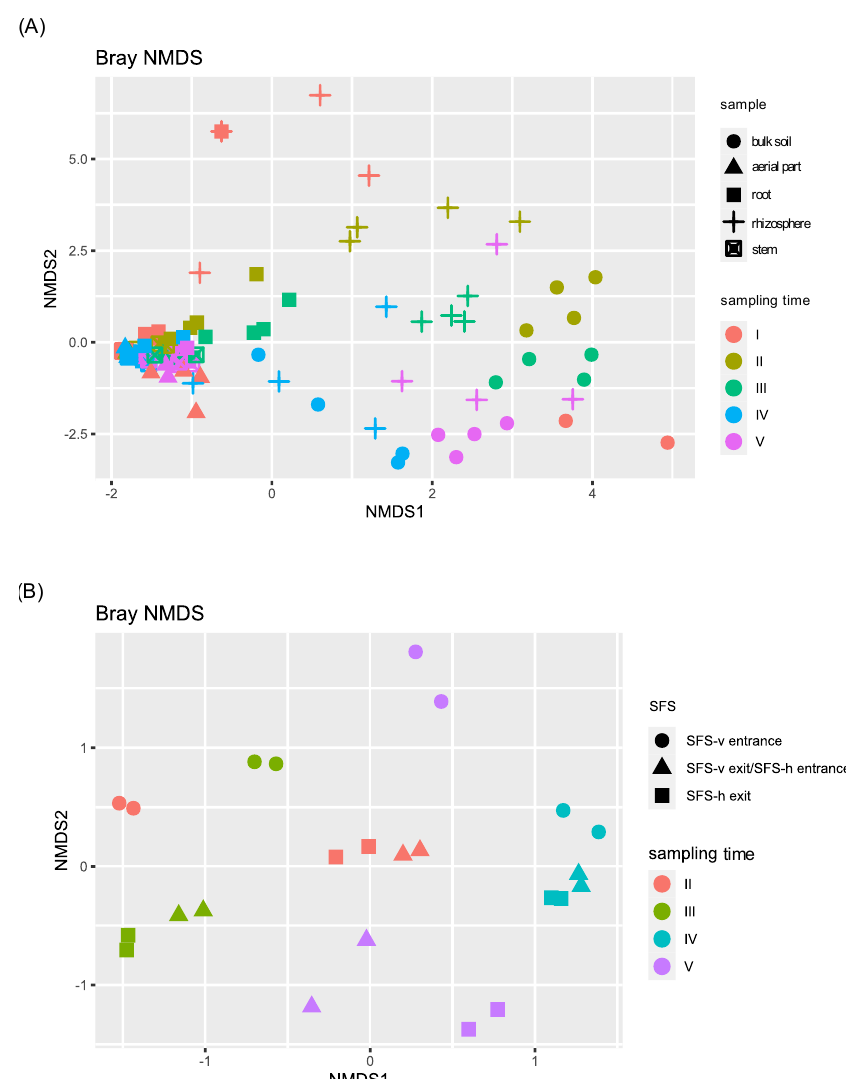
Figure 2. NMDS beta diversity of the bacterial communities of P. australis , soil and permeate samples. Samples were divided on the basis of the sampling site of the CW plant: ( A ) those collected directly from the SFS (plant tissues and soils) and ( B ) those collected from the CW irroration system (permeates).